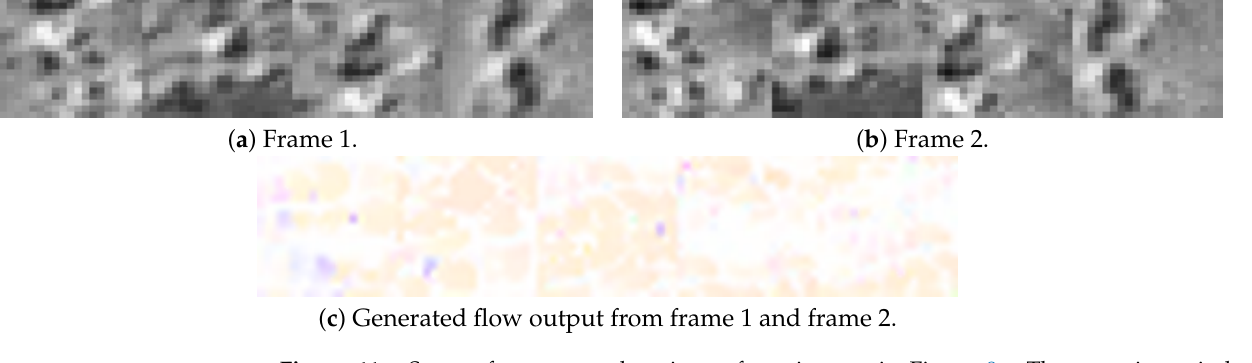
Figure 11. Sparse features used as input from images in Figure 9. The cropping window is 40 × 40 pixels and number of features is four. All images shown here were magnified for visual